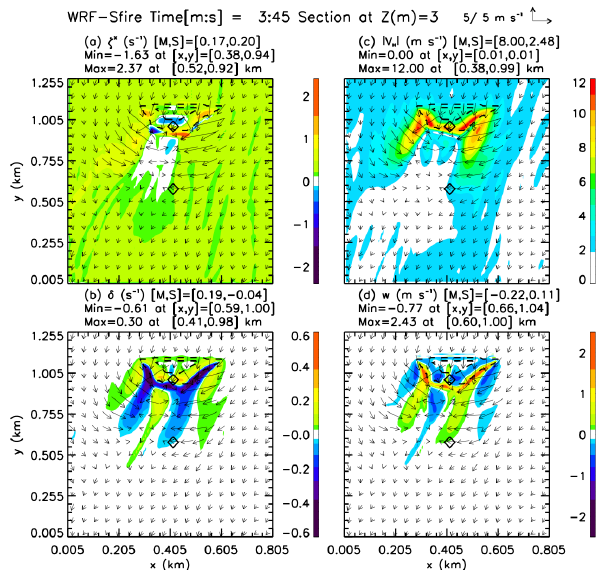
Fig. 10. Horizontal cross sections for 3ma.g.l. of (a) horizontal x vorticity ζ x (s − 1 ) , (b) horizontal divergence δ (s − 1 ) , (c) speed of horizontal wind | V H | (ms − 1 ) , and (d) vertical velocity w (ms − 1 ) at 3:45 [min:s] into the WRF-SFIRE simulation. Magnitudes of each contour are indicated by colors in bar plots on the right. For each field, minimum and maximum values, plus their ( x,y) positions on cross section are given. Vectors denote wind components in x – y plane where magnitude is scaled as indicated in the top right corner of plot. Black dotted contour lines delineate the surface fire perime- ter. Note that the (aspect) ratio between the height of each plot to its width is not equal to one. Plots show features lengthened in the y direction compared to the x direction. The ( x,y) locations of the MT and ST are indicated by black diamonds.